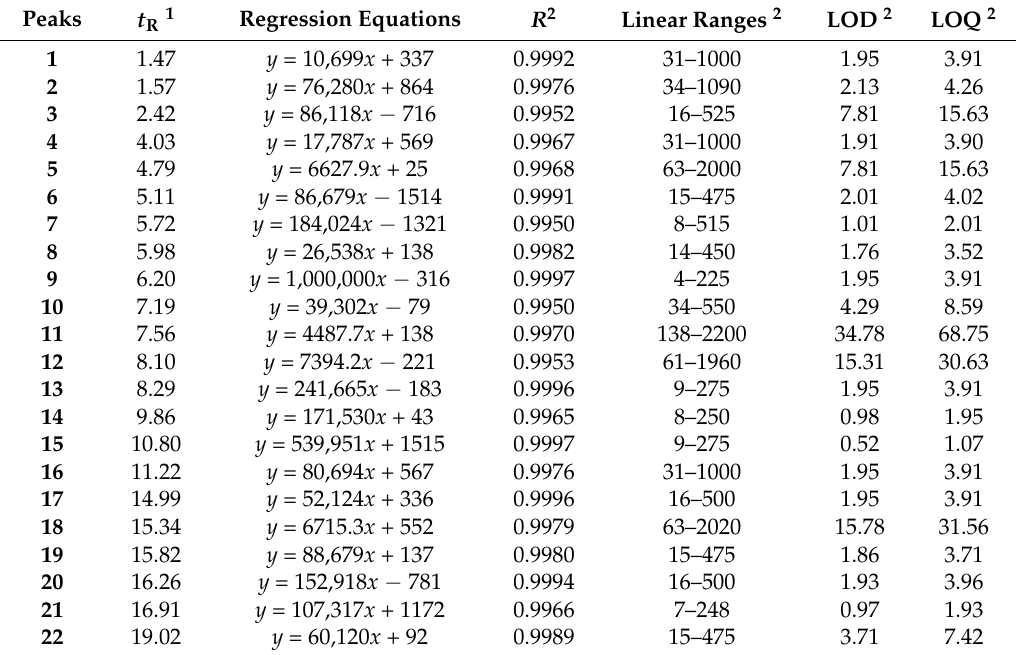
Table 2. Calibration curves and detection limit of 22 saponins in P. quinquefolium . Peaks t R